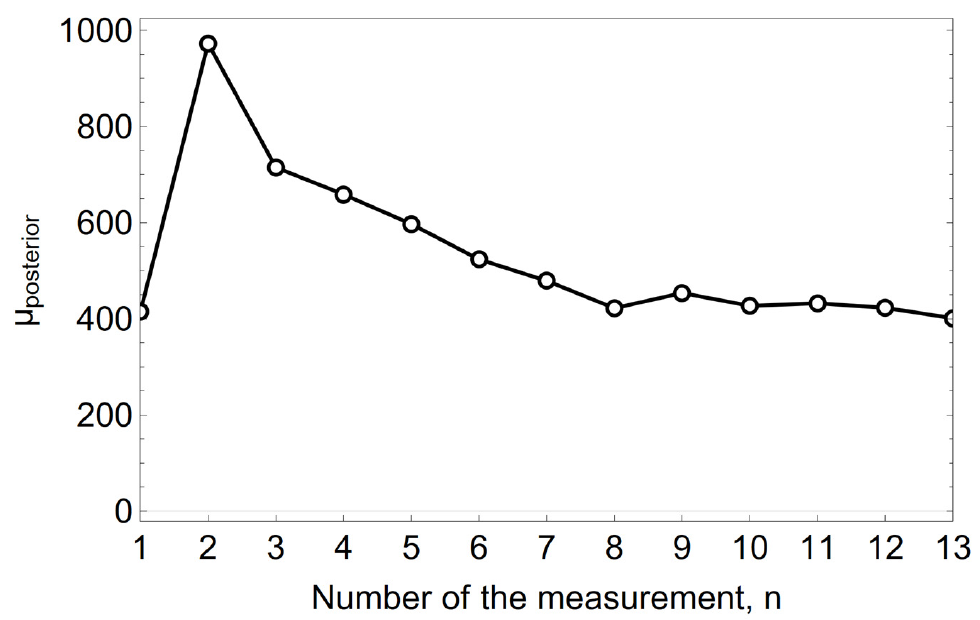
Figure 5. The variation of the mean value of µ µm heat —1 of the a posteriori distribution of the unit refractory wear rate in the spout zone.